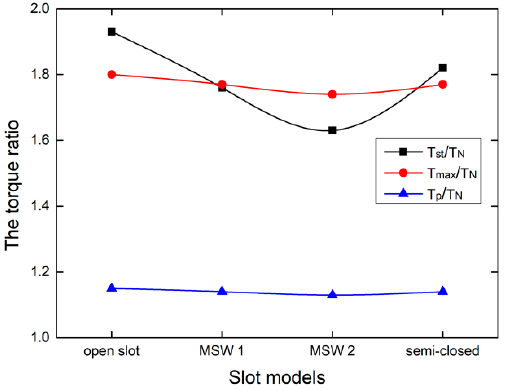
Figure 15. HVLSPMSM torque ratio.